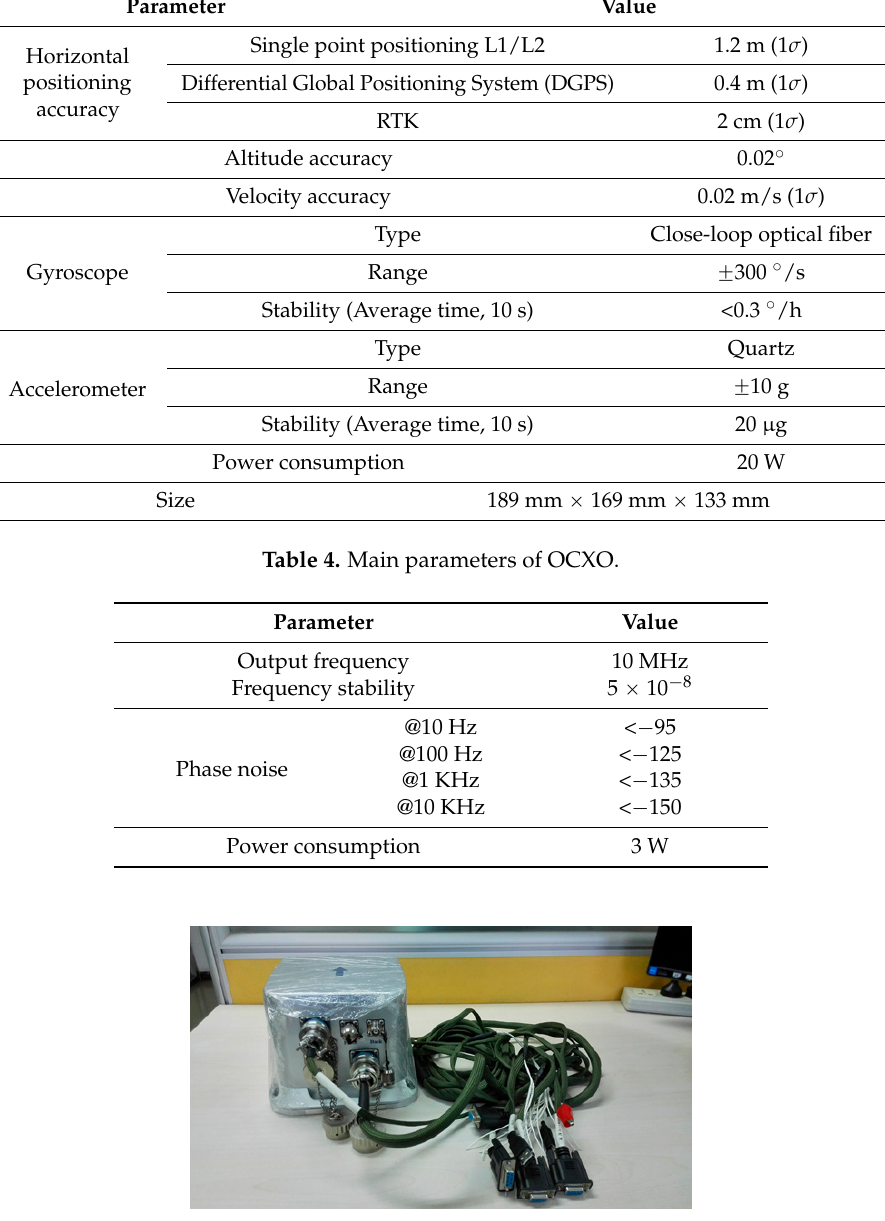
Figure 4. Photograph of GI7660.